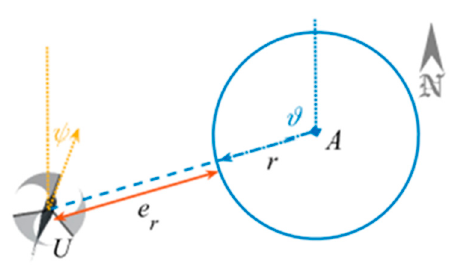
Figure 13. Diagram of circle